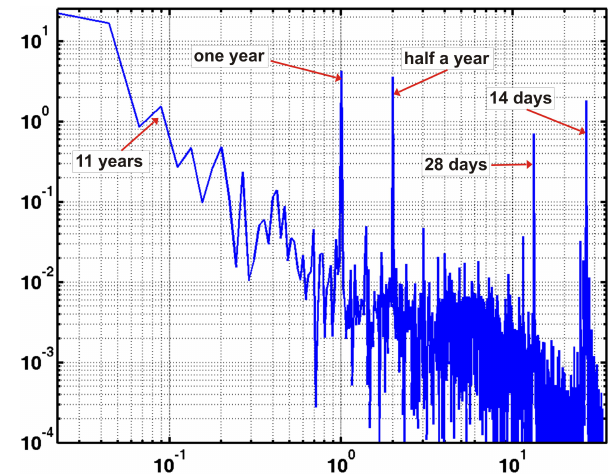
Fig. 7. Spectrum of monthly averages of the ν values on a log–log scale. The red lines with arrows indicate the representative peaks of the spectrum. The horizontal axis gives a number of cycles per